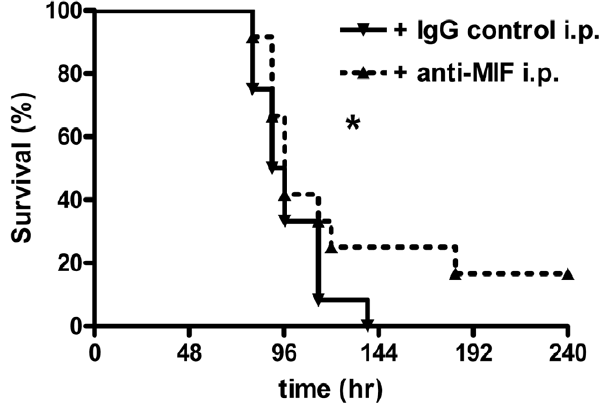
Figure 7. Effect of treatment with anti-MIF antibodies on survival of mice infected with B.pseudomallei . Mice were injected intraperitoneally with 2 mg of anti-MIF (straight line with downward arrow) or non-immune control IgG (dashed line with upward arrow) 2 hours before inoculation with 5.0 6 10 2 CFU of B. pseudomallei intranasally; n=12 mice per group; * p , 0.05.